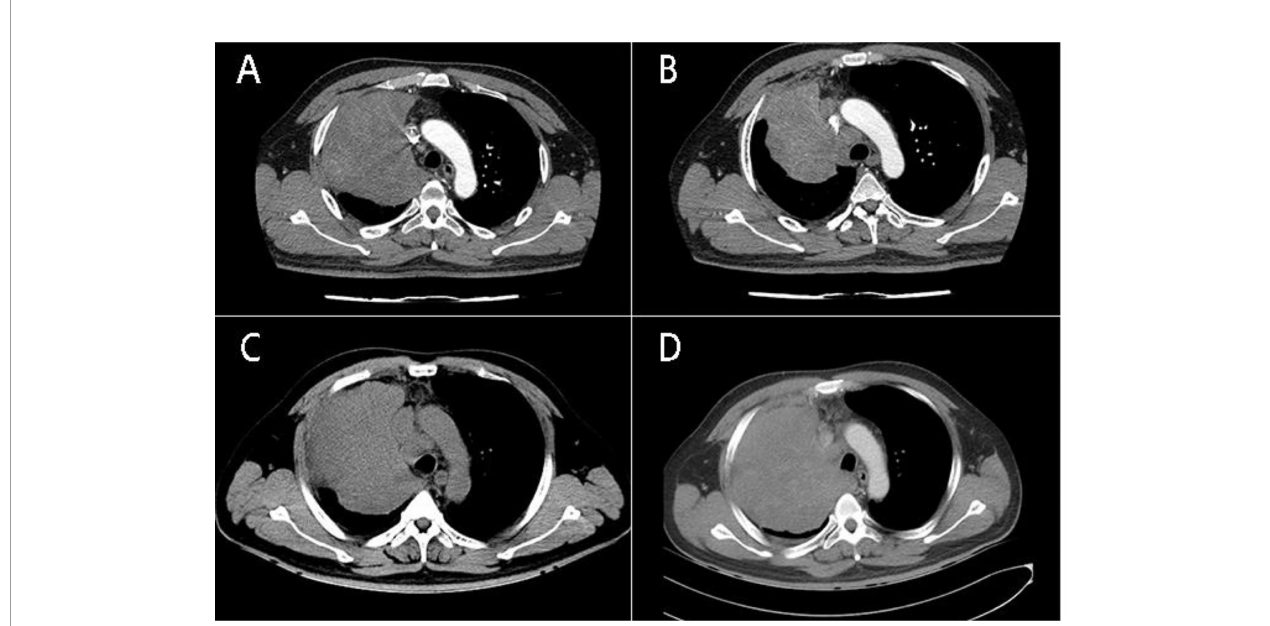
FIGURE 1 | (A) CT of the patient ’ s chest (July 10, 2018) shows: Massive soft tissue-like density shadows can be seen near the hilar of the right upper lung, the size is about 11.4cm* 10.7cm, the enhanced scan is uneven and moderately enhanced; (B) The patient ’ s chest CT (September 11, 2018) after VAI regimen chemotherapy showed that the size of the right lung mass was about 8.9*8.1 cm, which was smaller than before, but the mediastinal lymph nodes were enlarged; (C) (September 30,2018) The size of the right lung mass is about 12.1cm*10.5 cm, which is larger than before. (D) (October 11, 2018) The soft tissue-like density shadow of the right upper lobe of the right lung mass, the right hilum is compressed, the main trachea of the right lower lung is compressed and narrowed, and the righthilar and mediastinum have multiple enlarged lymph